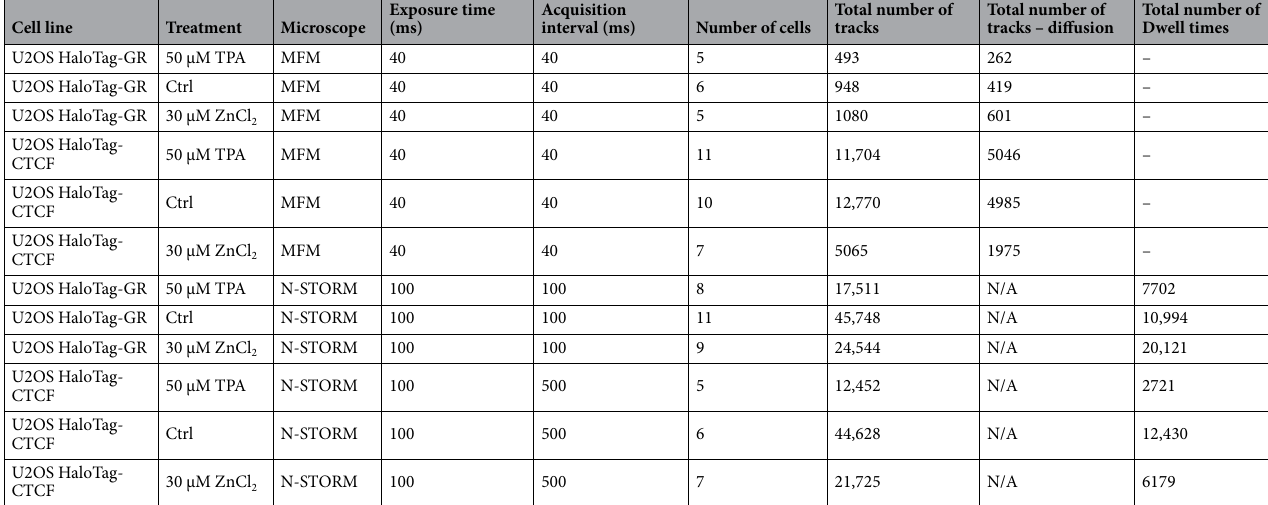
Table 1. Summary statistics for all cell lines and imaging conditions used in this study. Here, MFM denotes experiments conducted to generate 3D particle tracking data and N-STORM denotes experiments conducted to generate 2D particle tracking